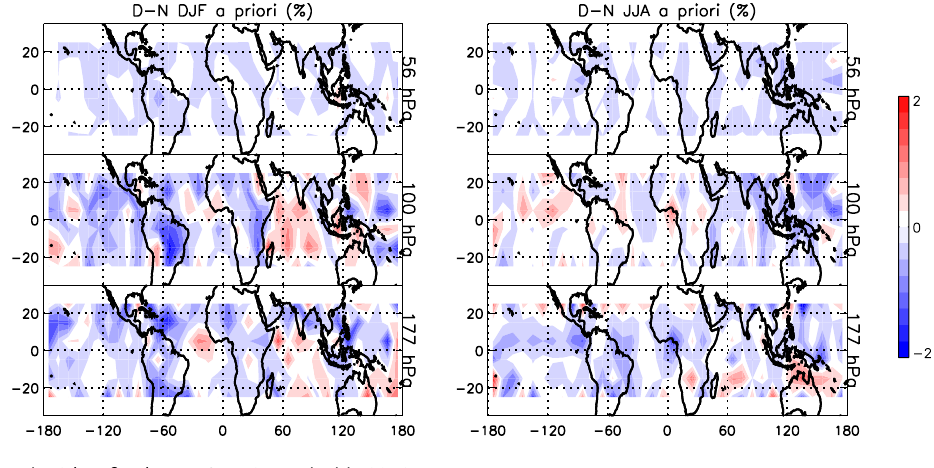
Figure 4. Same as Fig. 2 but for the MLS H 2 O a priori in 2012.